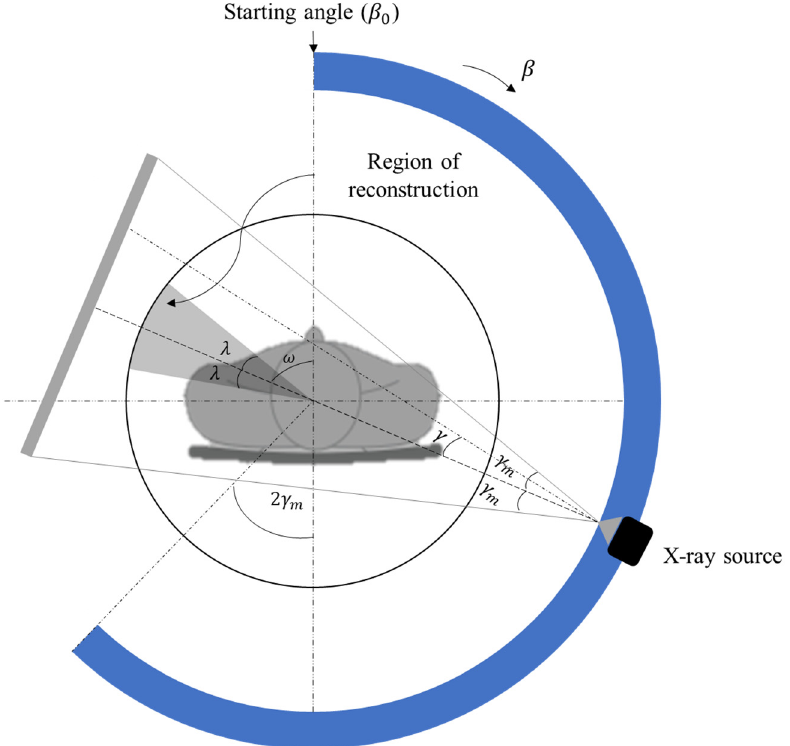
Figure 4. The half-scan geometry seen on the central plane. The half-scan range is from the starting angle ( β 0 ) to the end of the blue arc. The region of reconstruction for this half-scan range is the shaded fan of an angular span of 2 λ .